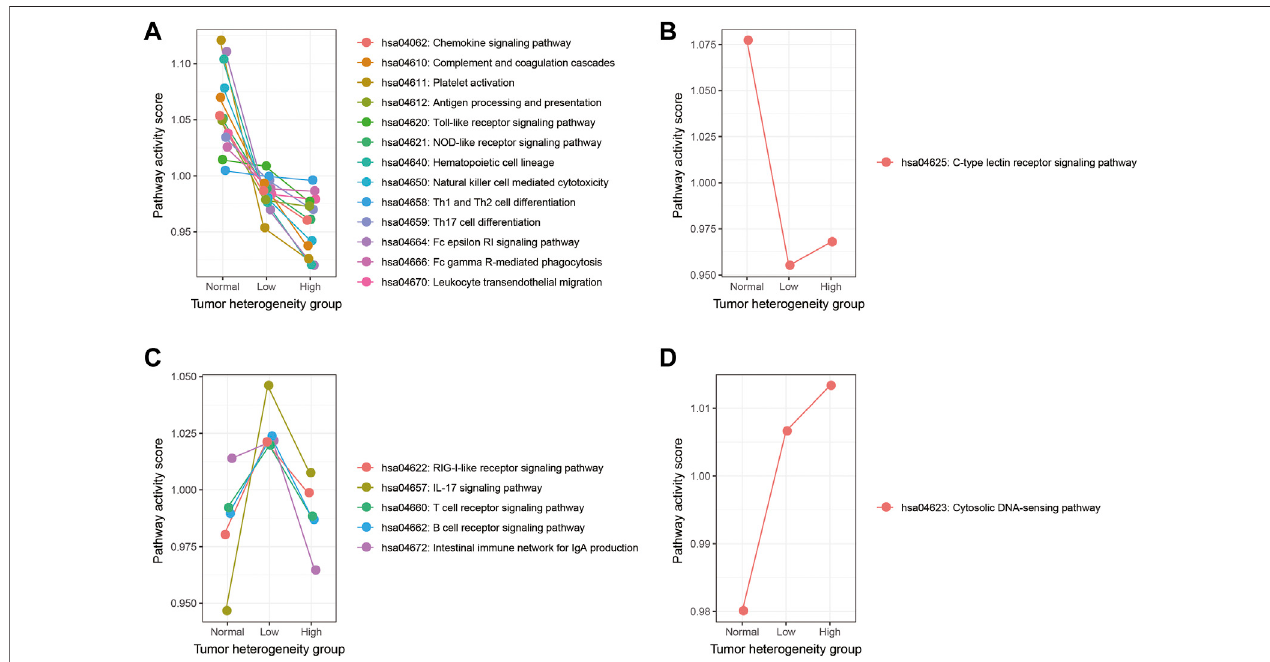
FIGURE 2 | Activity score of each immune pathway in three groups calculated by the Jason W. Locasale method. (A) Immune pathways which showed a continuous decreasing trend. (B) Immune pathways which showed a downward trend, followed by an upward trend. (C) Immune pathways which showed an upward trend, followed by a downward trend. (D) Immune pathway which showed a continuous increasing